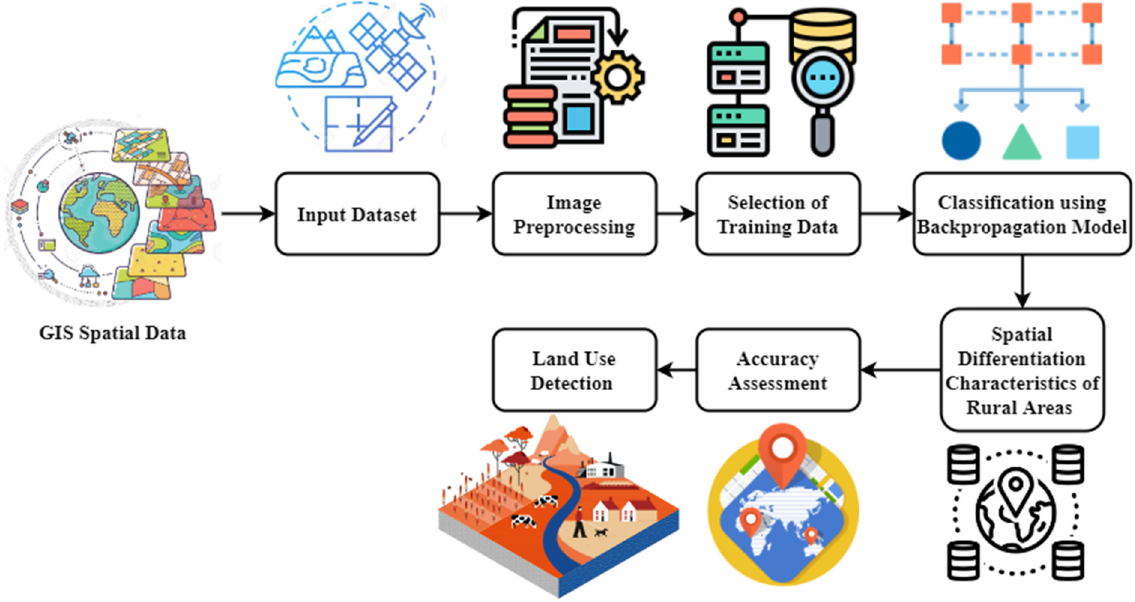
Figure 1. gis-sdm model.